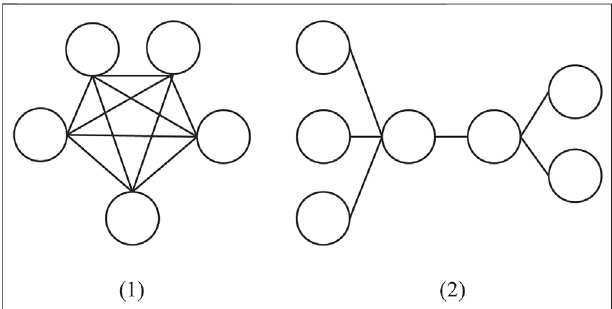
FIGURE 3 | Visual representation of the main components of domain models in network-based tutors. Note. The graph (A) to the left illustrate a full mesh topology. The graph (B) to the right illustrates a partial